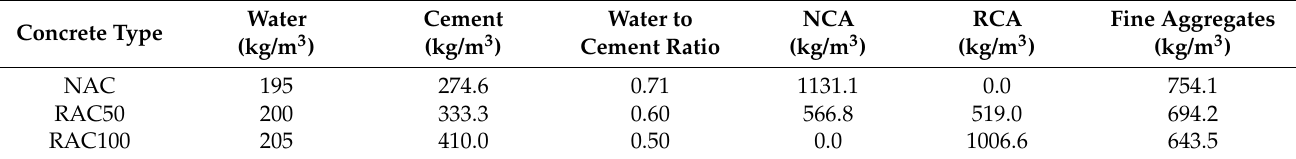
Table 3. Mix design proportions of NAC and